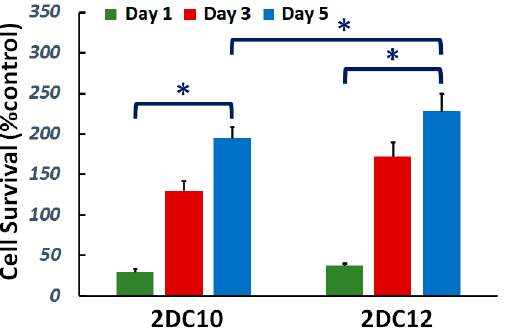
Figure 3. Cytocompatibility of nanohybrid alginate-GO hydrogels: effect of concentration of macromers on the cell viability (*: p < 0.05).